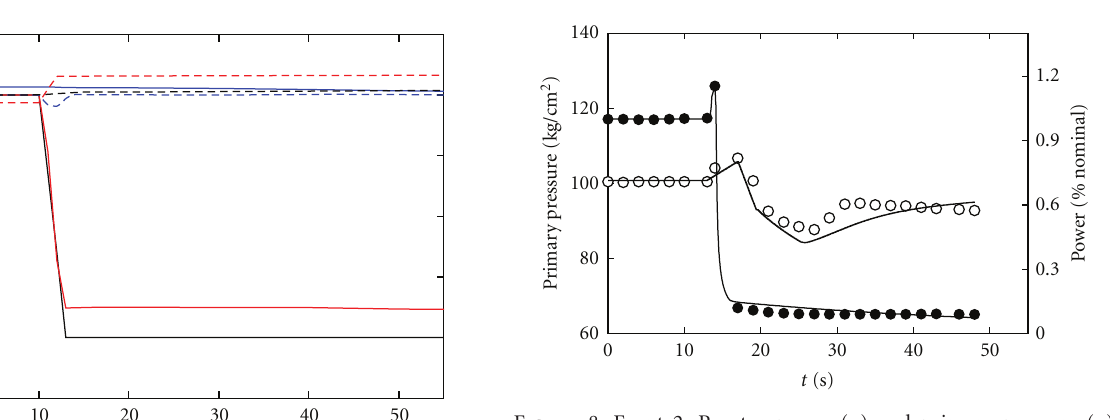
Figure 8: Event 2. Reactor power ( • ) and primary pressure ( ◦ ) responses to a positive reactivity injection and the loss of two primary pumps. The curves correspond to the simulation results.